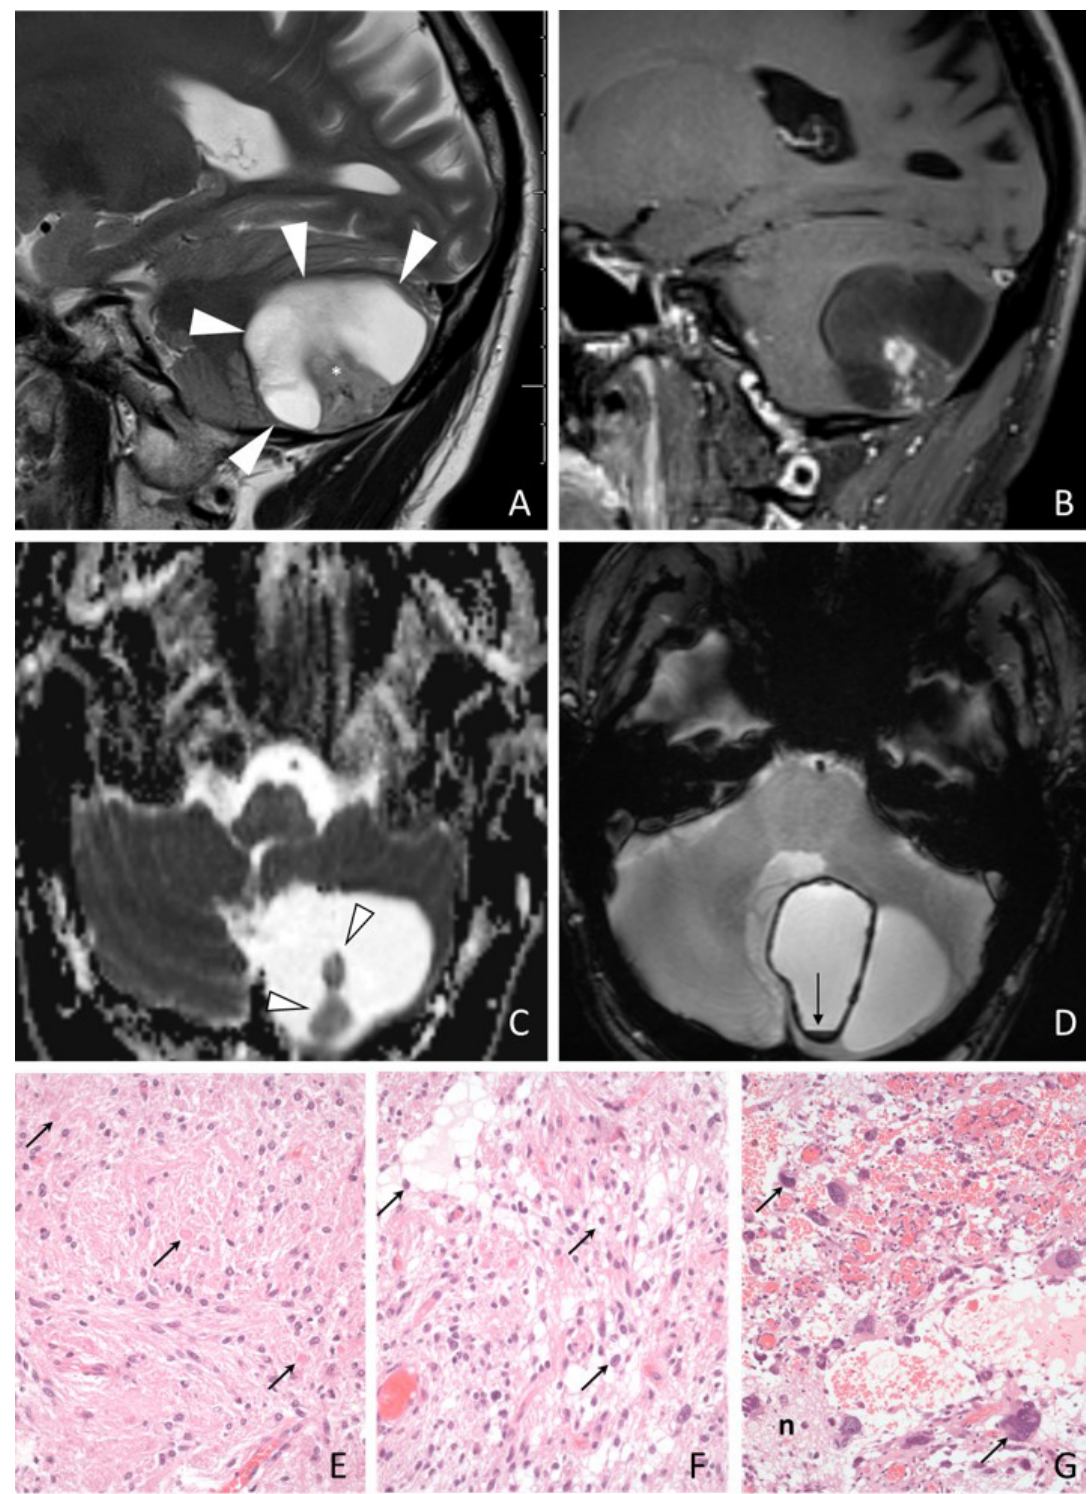
Fig.2. Case2. Cystic-HemorrhagicaPA.SagittalT2-weighted(A)andT1-weightedimagesaftercontrast(B)showaT2-brightcysticlesion(arrowheads),with a slightly hyperintense nodule with patchy enhancement located in the cerebellar hemisphere. ADC signal intensity (C) is slightly increased in comparison to the adjacent white matter (arrowheads). Axial T2*-weighted images (D) demonstrate signs of hemosiderin deposition lining one of the cyst walls, and a small fluidlevel,indicatingchronicintratumoralhemorrhage. Histologically,thesolidpartofthetumorcorrespondstoareaswithapiloidpattern,withcytologically bland cells and eosinophilic granular bodies (arrows in E), as well as other areas (F) with a looser architecture exhibiting microcystic changes, round-to-ovoid cells (arrows), a pseudoangiomatous hypervascular pattern and large pleomorphic cells (arrows in G). These were interpreted as regressive changes, because of the presence of only rare mitoses and the very low Ki-67 proliferative index (about 3%).